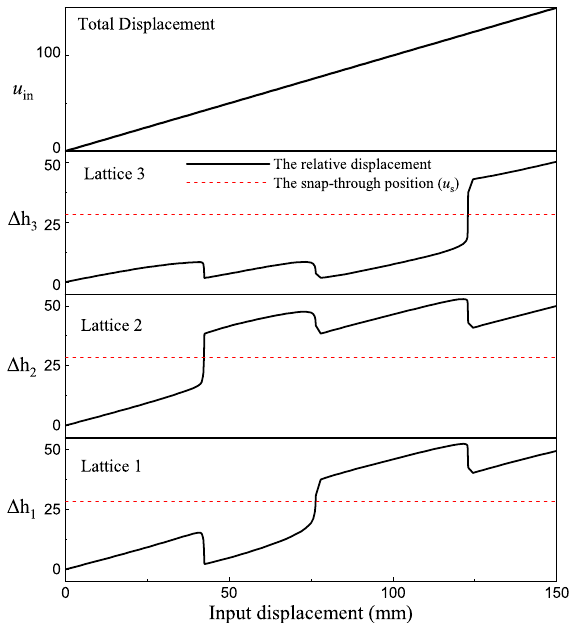
Figure 10. The displacement of each element under the load of input